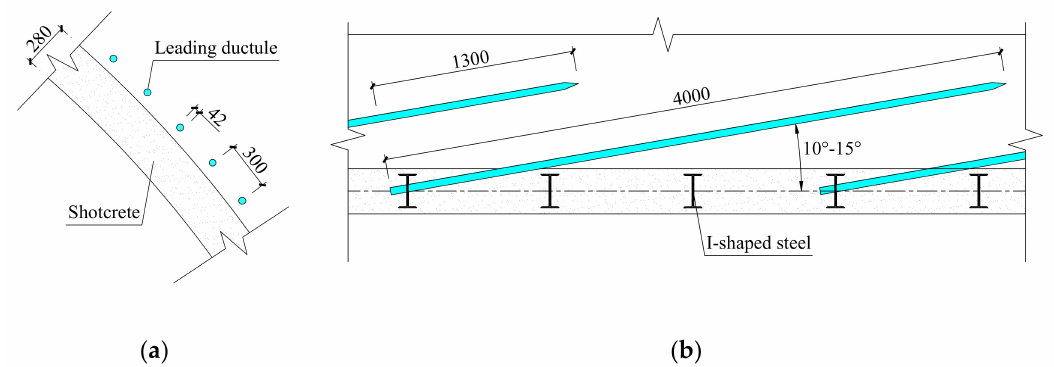
Figure 7. Schematic image of the leading ductule (unit: mm): ( a ) Cross section; ( b ) Longitudinal section.